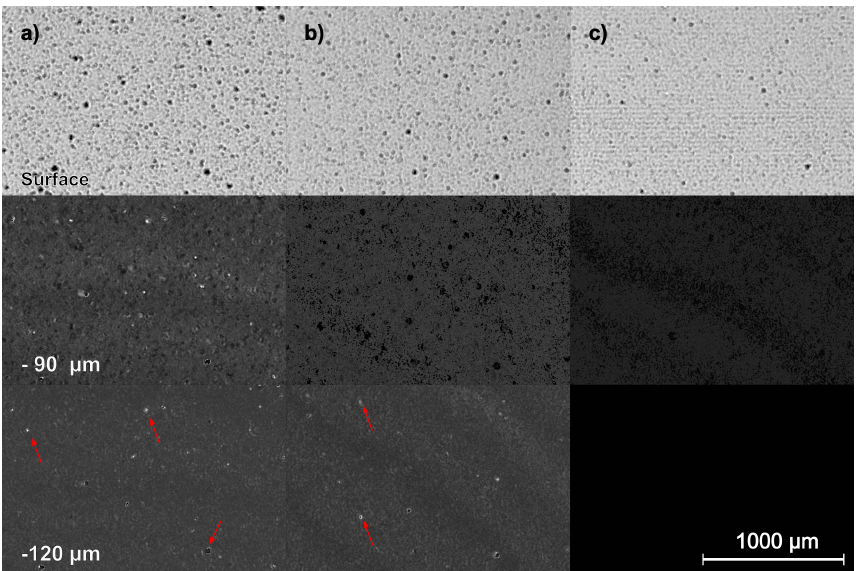
Figure 15. SAM micrographs showing the composition at the surface, a depth of − 90 and − 120 micrometer of ( a ) ground ( b ) brittle material removal milled ( c ) ductile cutting regime milled. Note: